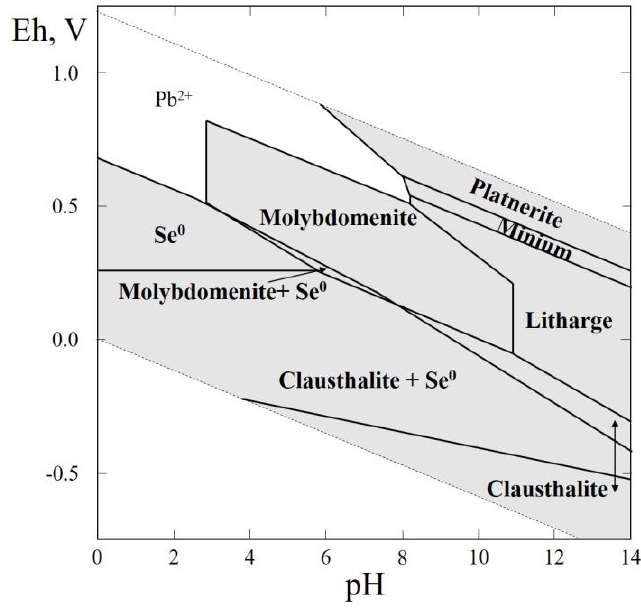
Figure 6. Eh – pH diagram of the OSePb (Pb – Se – H 2 O) system at 25 °C and the activities of the components: a ΣSe = 10 − 4 , a ΣPb = 10 − 4 .